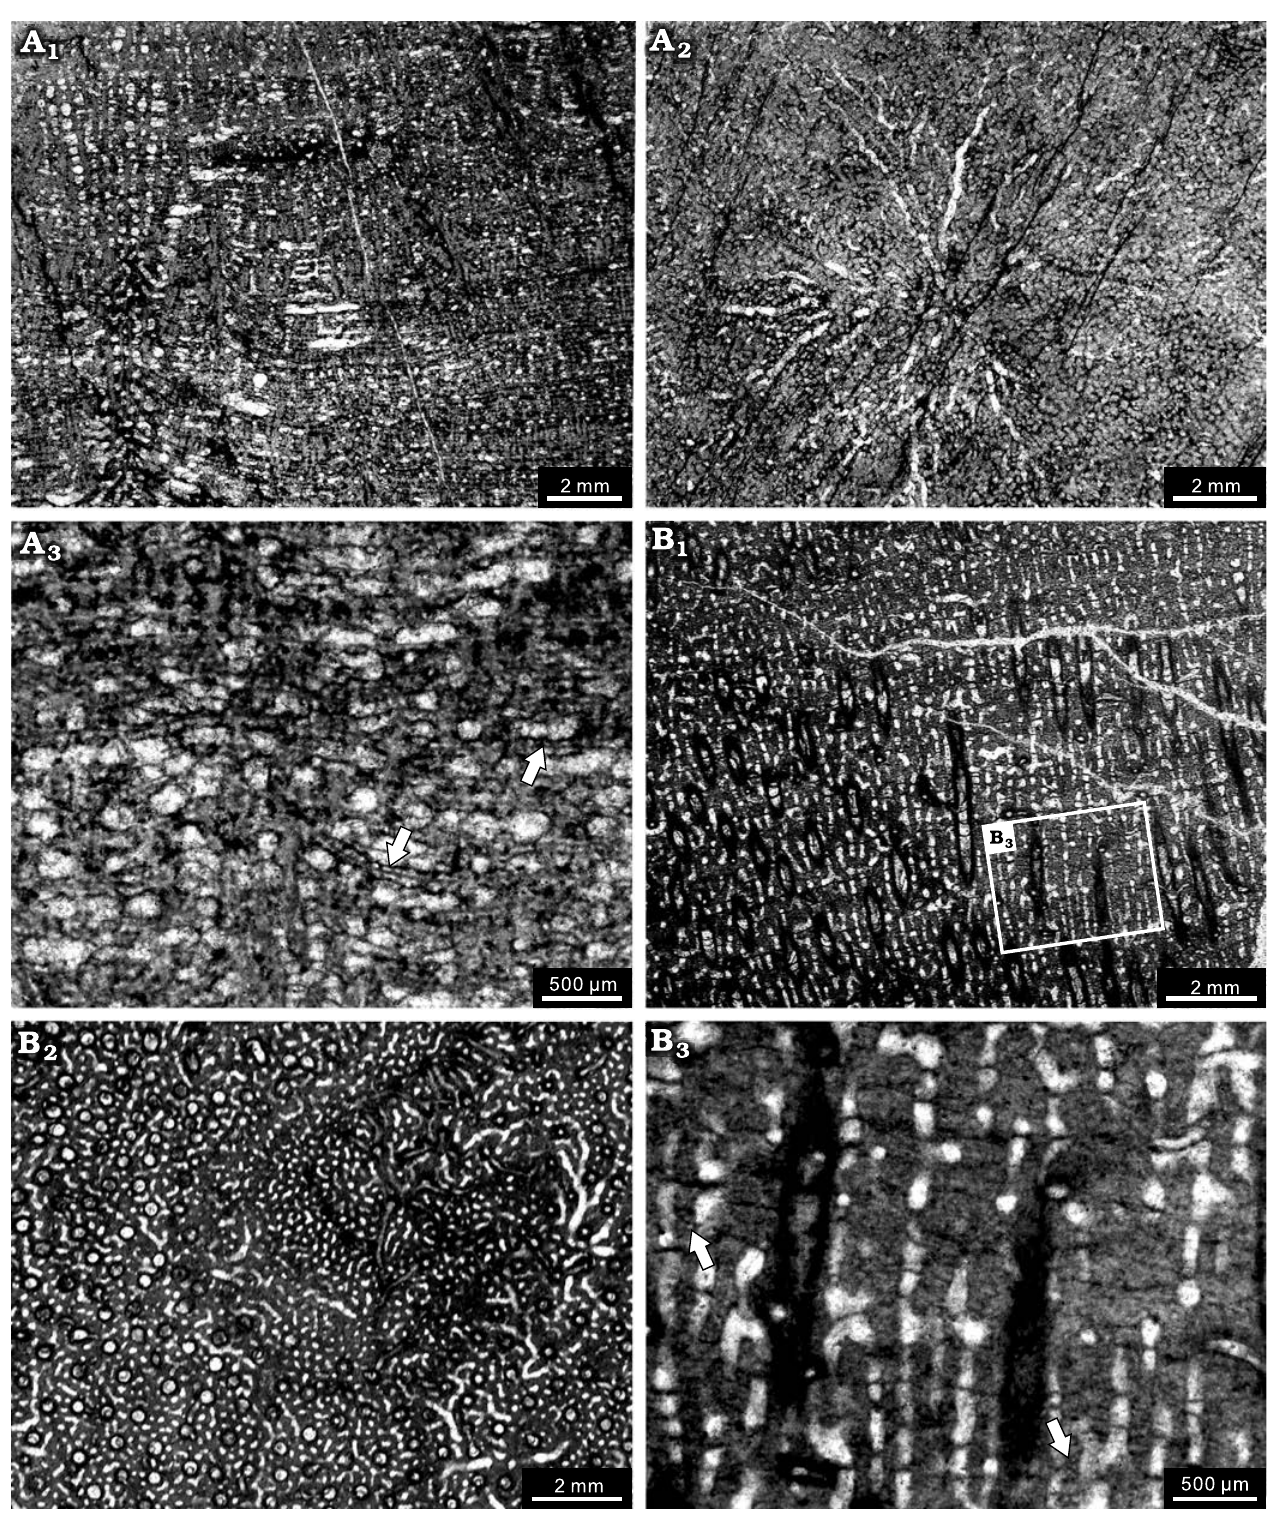
Fig. 8. Stromatoporoids from the Jiwozhai reef, Jiwozhai Member, Dushan Formation, Givetian, Middle Devonian; Dushan, Guizhou, South China. A . Pseudotrupetostroma porosum (Yang and Dong, 1979), NIGP 177053; A 1 , longitudinal section; A 2 , tangential section; A 3 , enlargement of longitudi- nal section showing coarsely cellular microstructure coated tangential elements (arrows). B . Salairella buecheliensis (Bargatzky, 1881), NIGP 177054; B 1 , longitudinal section, note the predominance of the pachysteles in the right standard area and amalgamated structure in the left oblique orientation of the thin section; B 2 , tangential section, note the autotubes in the upper middle area; B 3 , enlargement of B 1 showing coarsely cellular microstructure (arrows) partially transformed into melanospheric microstructure; such features demonstrate the likely diagenetic character of these microstructures and therefore their unreliability as taxonomic